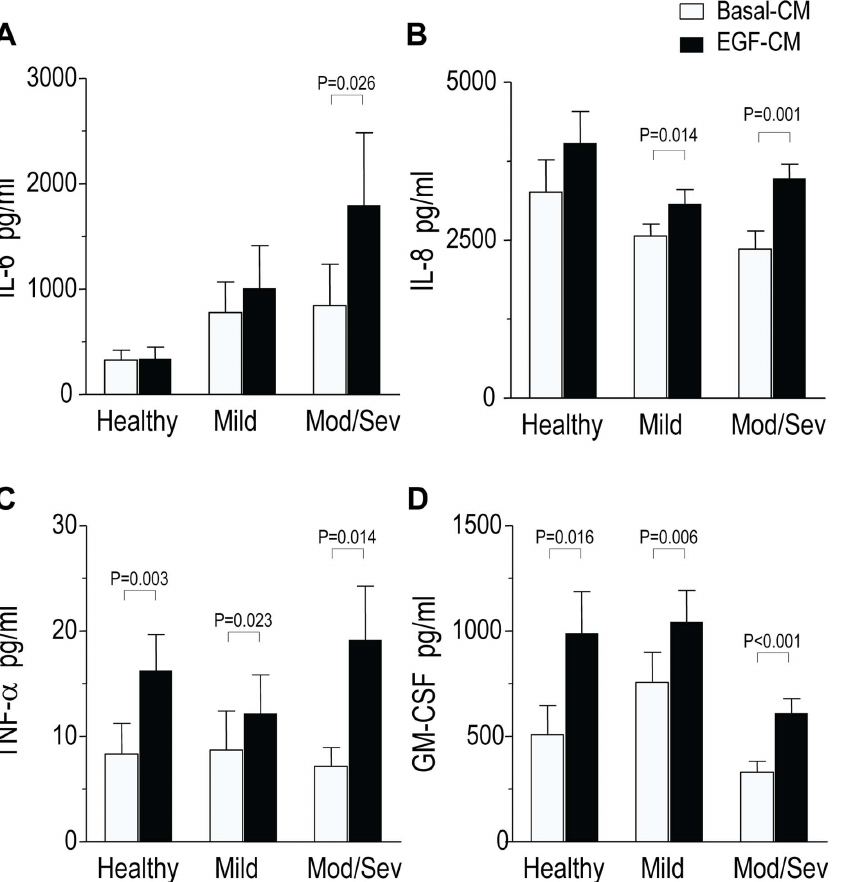
Figure 3. Induction of soluble mediator release by the asthmatic and normal bronchial epithelial cells in response to EGF stimulation. In Mod/Sev asthmatics ( n =11 patients), a significant induction of all four pro-inflammatory cytokines was seen, whilst in MA subjects ( n =8 patients), three of four mediators were induced; in the HC subjects ( n =9 donors), only two mediators were induced significantly. Linear contrast testing did not show any disease related trend in mediator production.